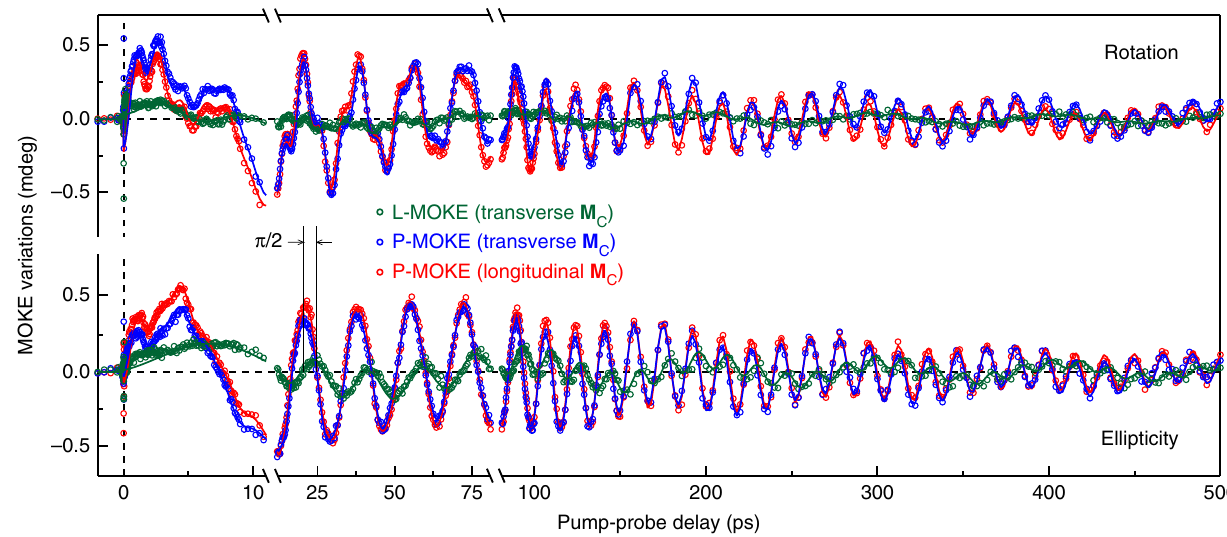
Figure 3 | STT-induced magnetization dynamics. Transient MOKE signals in both rotation (top) and ellipticity (bottom). Polar (P-) and longitudinal (L-) MOKE effects are separated. Solid lines are the results of the fitting procedure with a set of exponentially decaying oscillations with their frequencies given by equation (2). The pronounced similarity between the two P-MOKE traces (red and blue dots) demonstrates the robustness of the measurements. The indicated p /2 phase shift between the P- and L-MOKE components confirms the precessional nature of the magnetization dynamics.